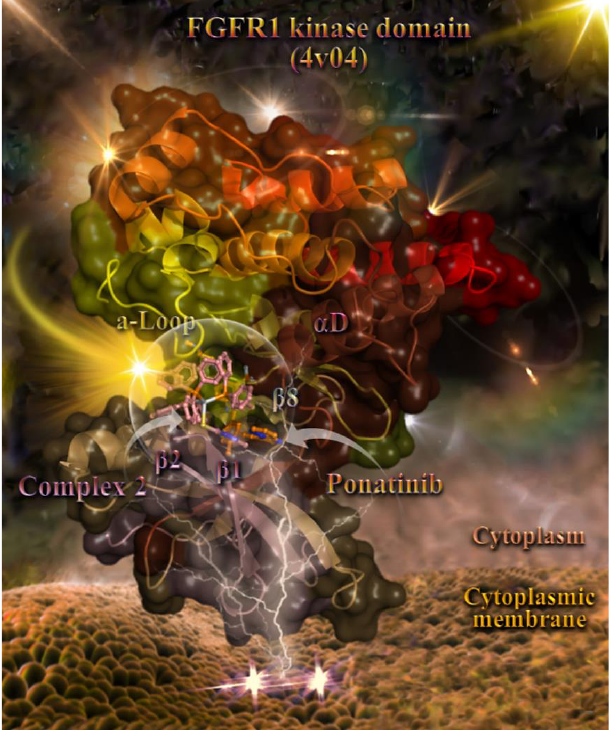
Figure 9. Docking pose orientation of compound 2 in the crystal structure of the catalytic domain of fibroblast growth factor receptor 1 (FGFR1) kinase in a complex with its inhibitor drug ponatinib (PDB accession number: 4V04). FGFR1 is localized in the cytoplasmic membrane towards the intracellular cytoplasm (transmembrane and extracellular domains are not shown). The target protein is illustrated as a cartoon and the docked 2 as well as the superimposed co-crystallized inhibitor ponatinib are rendered in ball-and-stick mode and colored according to atom type in salmon and orange, respectively. FGFR1 protein’s segments: activation loop (a-Loop); aD helix; and β1, β2, and β8 antiparallel beta sheets forming the binding pocket of 2 are depicted in the structure colored according to cartoon (split pea green, chocolate, salmon, salmon, and split pea green, respectively). A-loop is depicted in its active (open) conformation. Complex 2 is found adjacent to ponatinib at the ATP-binding cleft of the protein. Heteroatom color-code: O: red, N: blue, S: yellow, P: orange, and Ag: gray. Hydrogen atoms are omitted from all molecules for clarity. The final structure was ray-traced and illustrated with the aid of PyMol Molecular Graphics Systems.